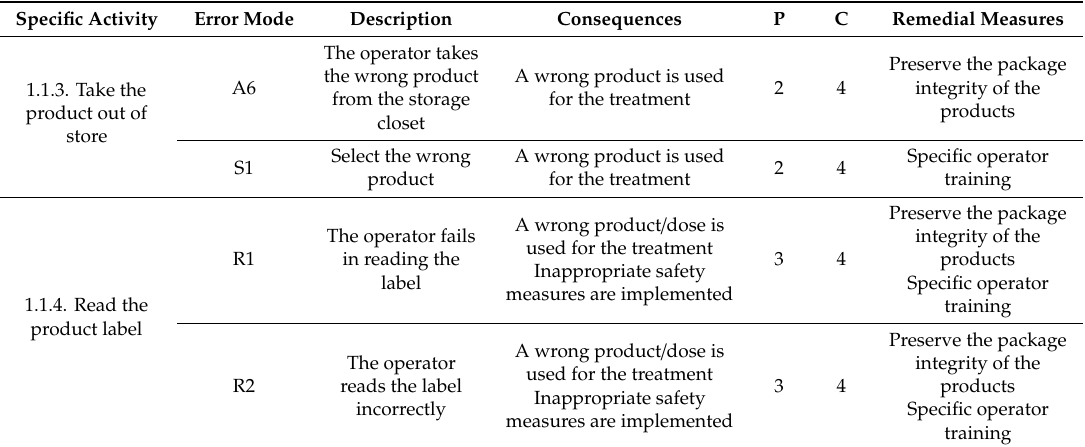
Table 4. Excerpt of the SHERPA table.